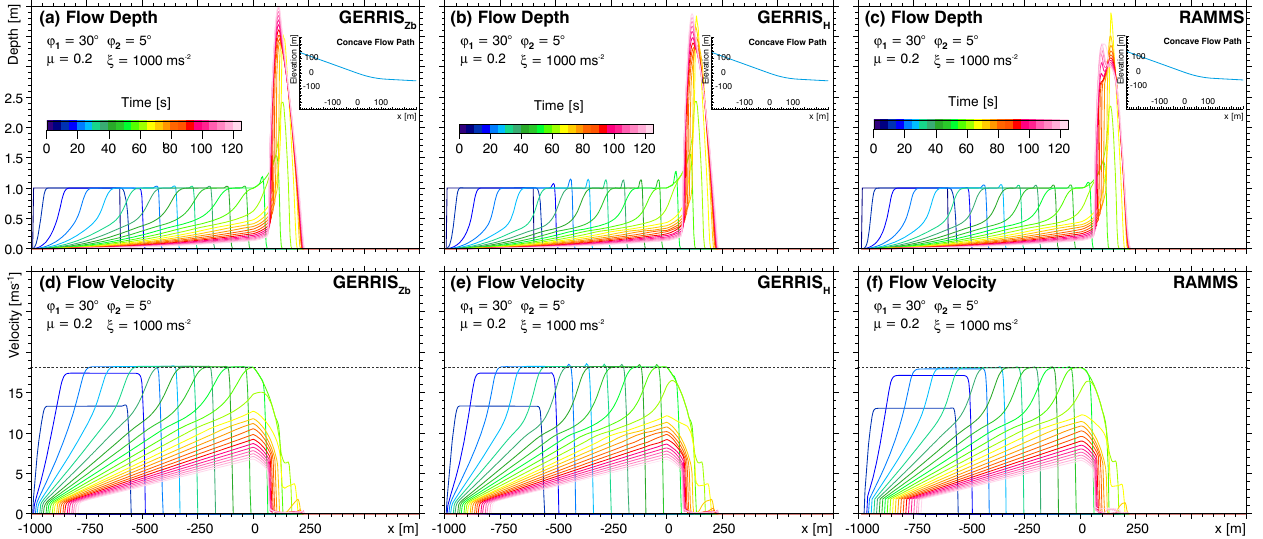
Figure 5. Time series of longitudinal profiles plotted every 5 s for flow depth and flow velocity of the scenario shown in Fig. 4. Profiles are based on numerical solutions of (a, d) GERRIS Zb (b, e) GERRIS H , and (c, f) RAMMS. The insets show the topographic profile.